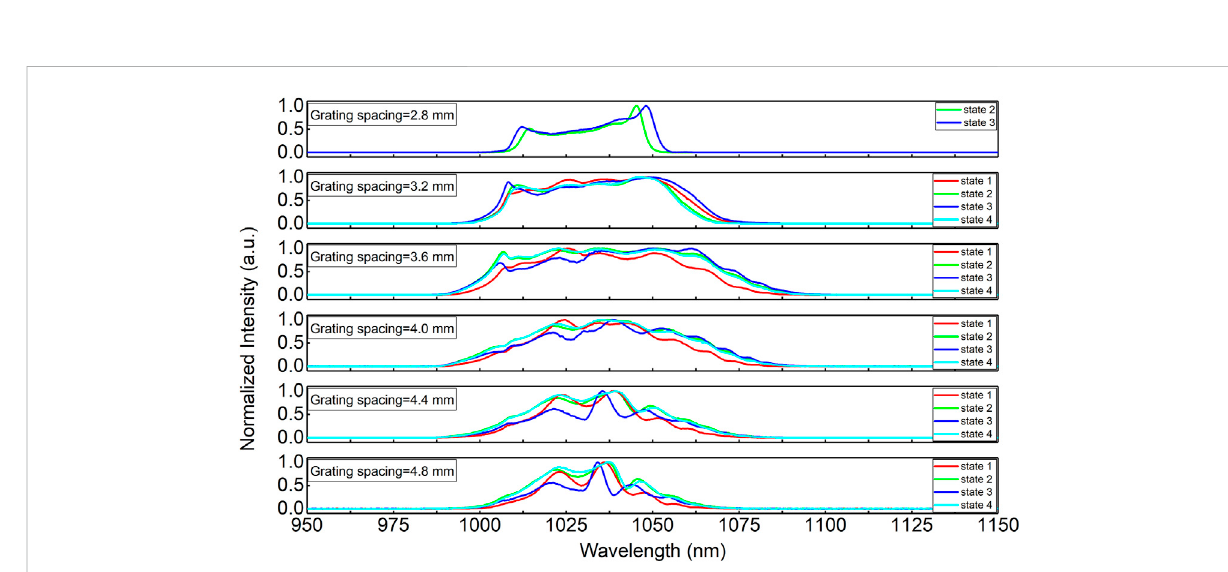
Oscillator spectra in different grating spacings and different intracavity polarization